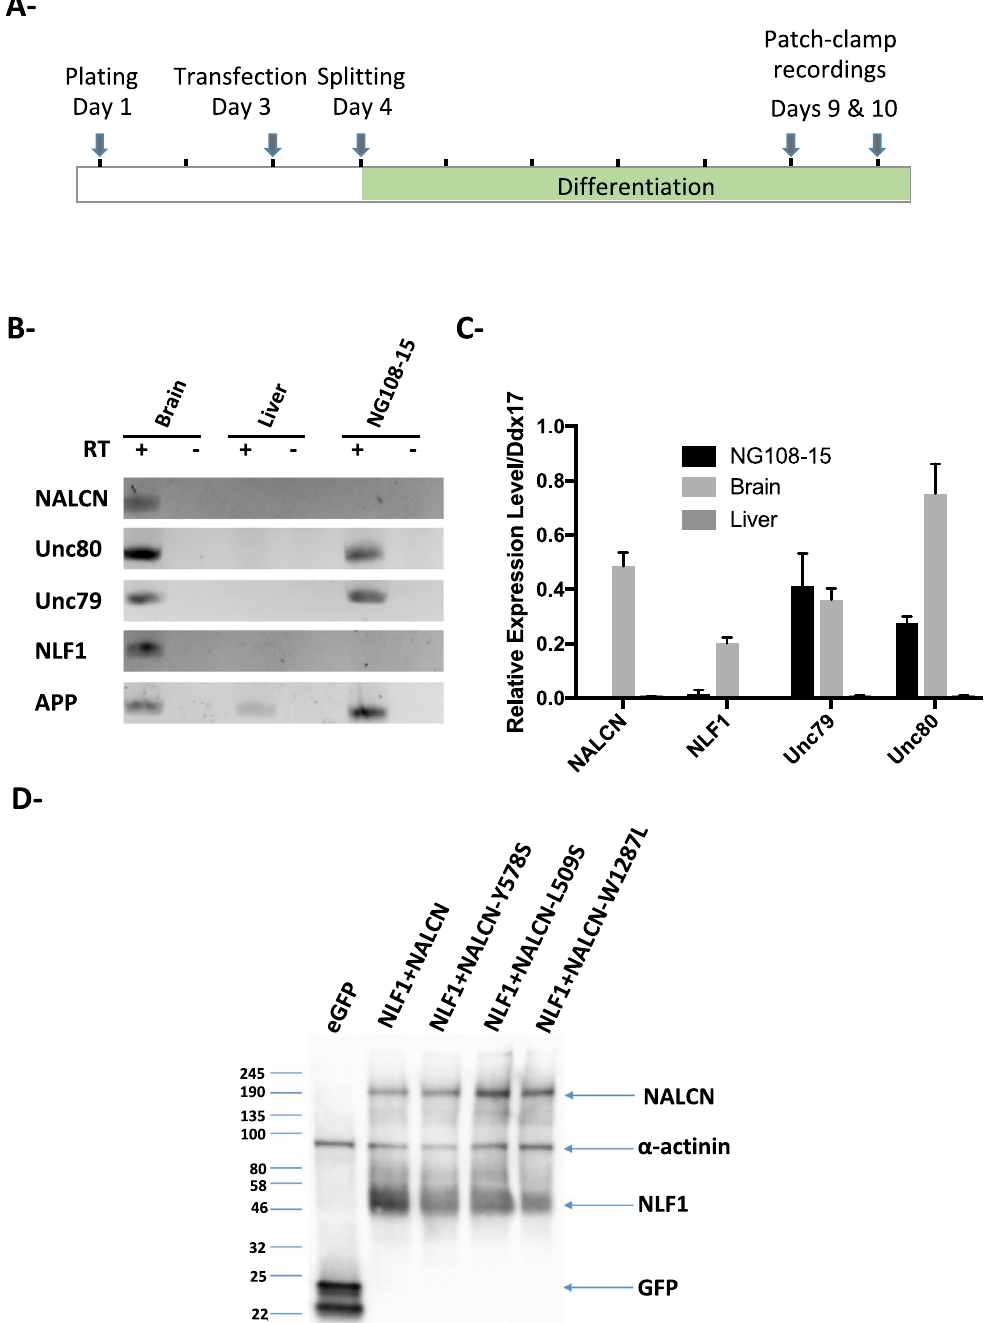
Figure 1. The NG108-15 cell line endogeneously expresses Unc79 and Unc80. ( A ) Schematic representation of the protocol used to achieve differentiation of NG108-15 cells into neuron-like cells. ( B ) RT-nqPCR with total RNA extracted from differentiated NG108-15 cells, rat adult brain and rat adult liver. The + and − symbols indicates the presence or the absence of the Reverse Transcriptase respectively. The ubiquitously expressed transmembrane Amyloid Precuror Protein ( App )-encoding mRNA was used as an internal control. ( C ) RT- qPCR results with the same RNA samples than in B- showing that both Unc79 and Unc80 , but not Nalcn and Nlf1 , are expressed in differentiated NG108-15 cells. The gene encoding the RNA helicase Ddx17 was used as a housekeeping gene (n = 4). ( D ) Representative western blot showing that transfection of the wt NALCN- and its pathogenic variants W1287L, Y578S, L509S, and NLF1-encoding cDNAs in NG108-15 cells results in a high expression level of the corresponding proteins, but not in the eGFP